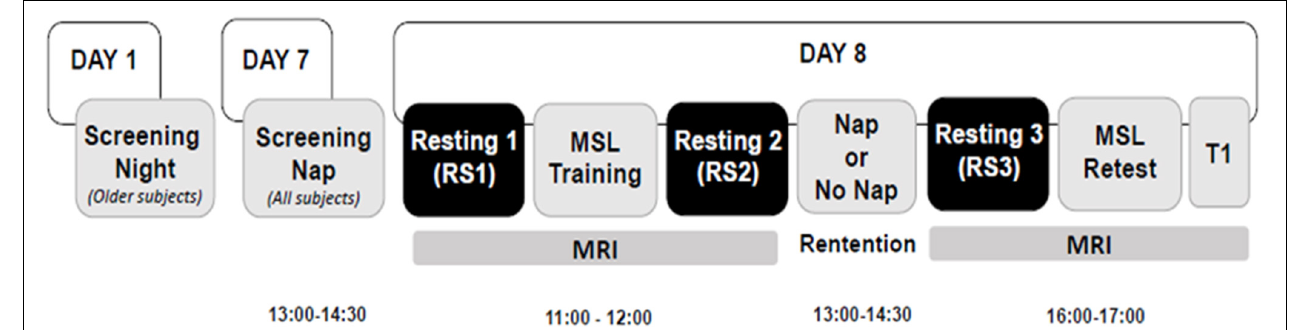
FIGURE 1 | Experimental design. Older participants underwent an overnight screening night (Day 1), 1 week prior to the screening nap. Then all participants underwent a screening nap (Day 7) from 13:00 to 14:30 and returned on the following day for the remainder of the experimental protocol (Day 8), on which day two MRI scan sessions were performed. The morning MRI session took place at 11:00 and lasted ∼ 45 min. It consisted of an MSL task training session, and two resting scans, one was before the MSL session (RS1), the other was immediately after the MSL session (RS2). Participants were then assigned to either the Nap or No Nap condition. The retention interval began at 13:00 and lasted 90 min, with an additional > 1 h for recovery from any sleep inertia effects. The afternoon MRI scanning session began at 16:00 and lasted ∼ 45 min, which comprised a resting scan (RS3) session followed by the MSL task retest session and a T1-weighted anatomical scan